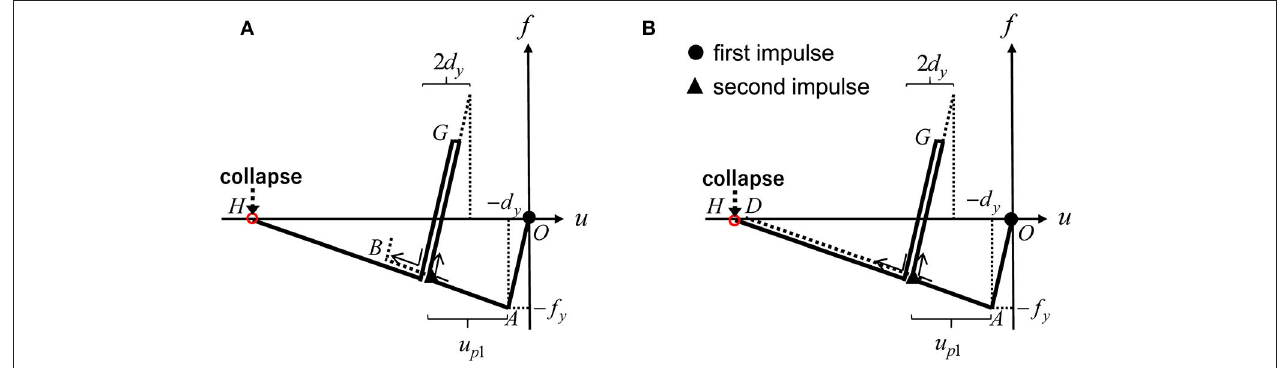
FIGURE 8 | Restoring-force characteristic corresponding to collapse pattern 4 ′ , (A) Case-B and CASE-II, (B) Case-C and CASE-II.